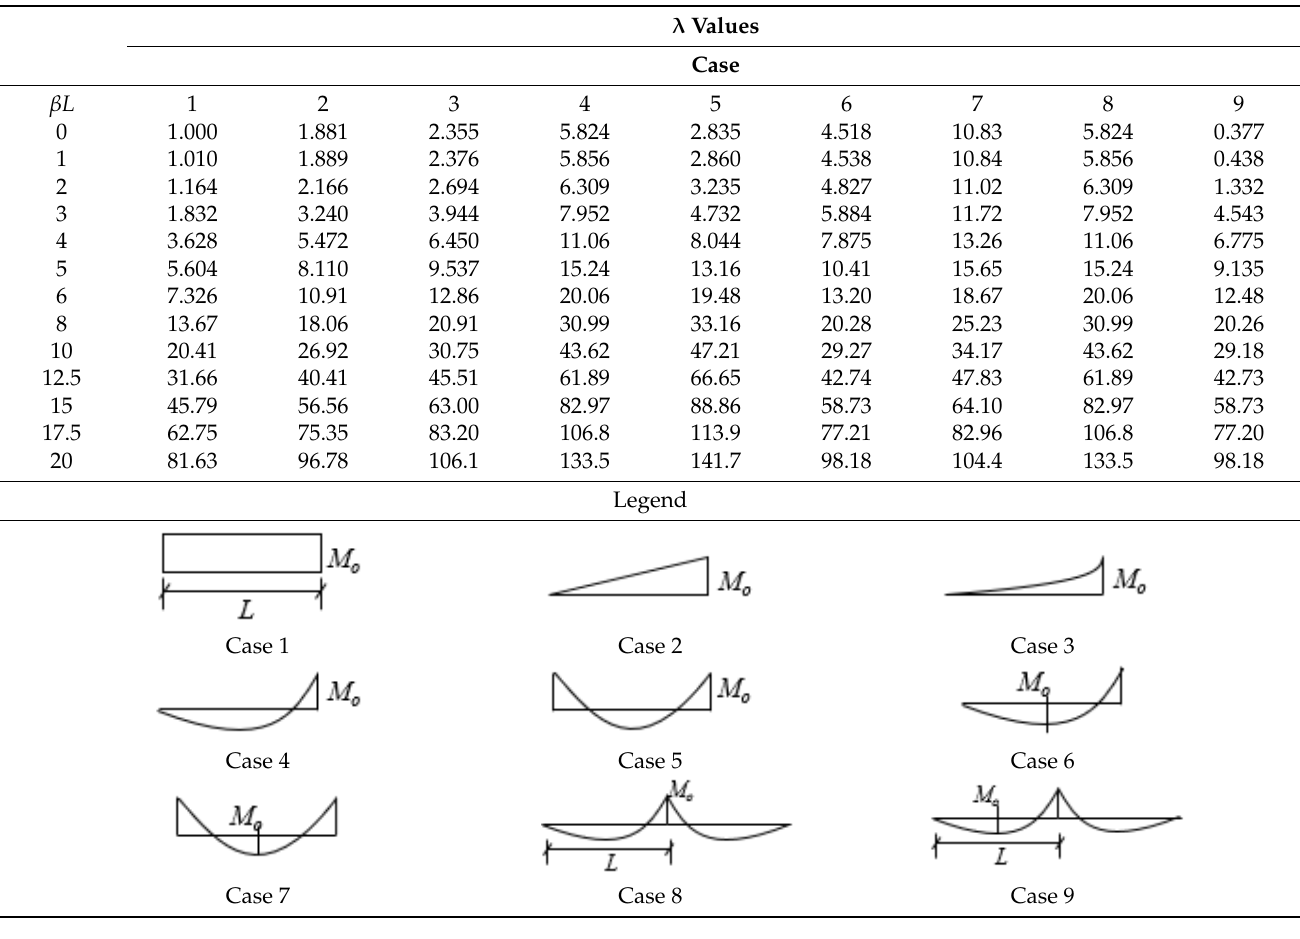
Table 2. λ values for different bending moments [121]. Adapted from Svensson [121].